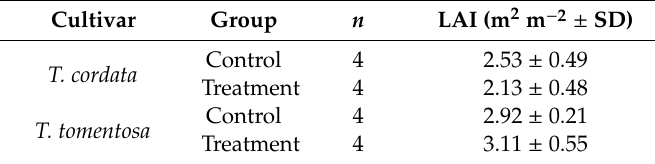
Table 2. Leaf area index (LAI; m 2 m –2 ) of the two tree cultivars from both the control and treatment groups in June 2017.